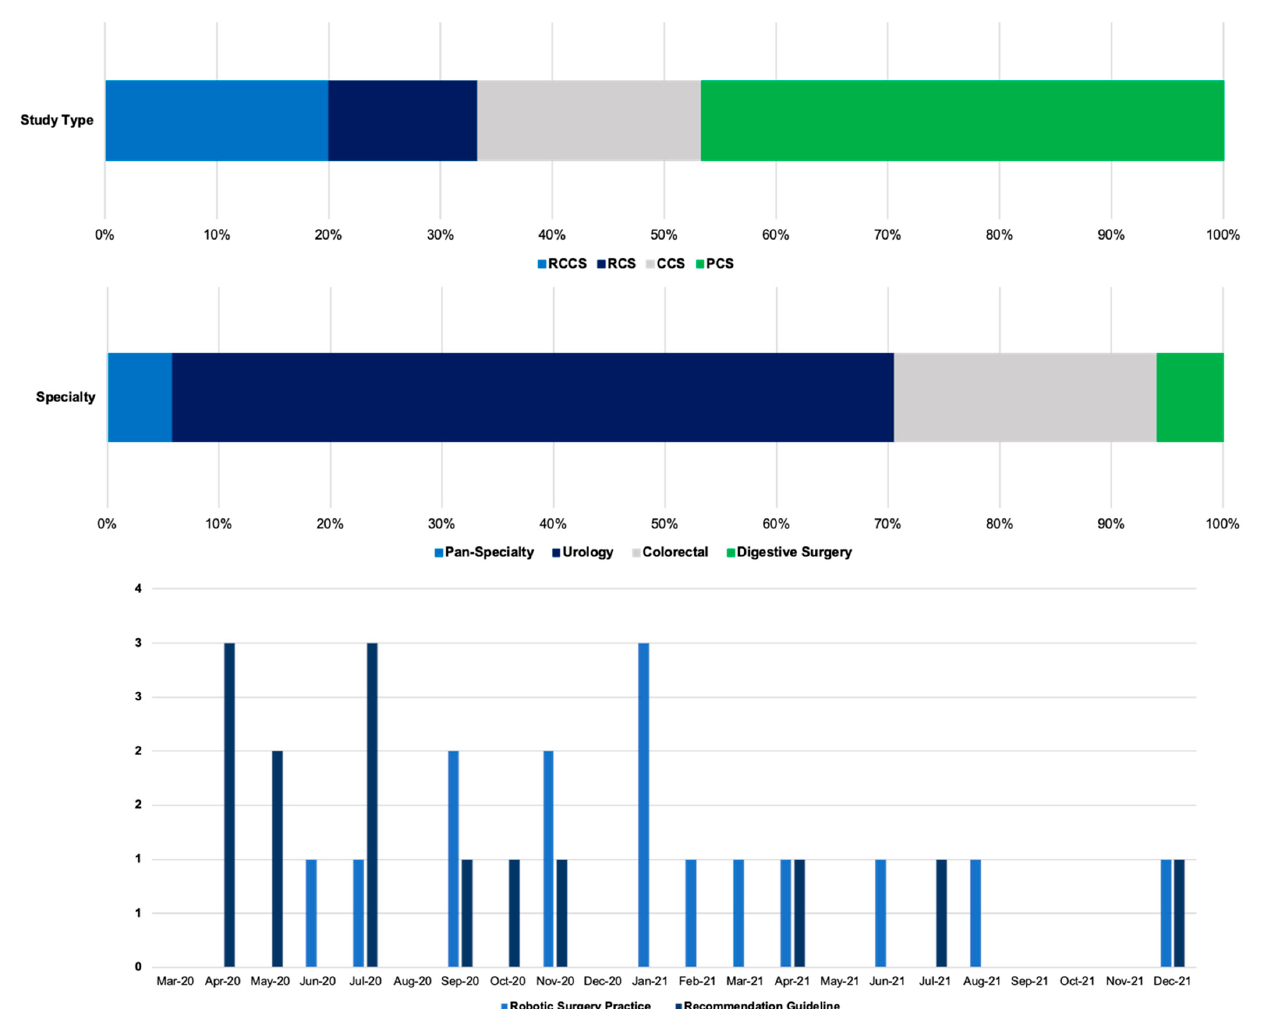
Figure 2. AGREE-II Comparison. Figure 3. Study type and relevant surgical specialty for publications related to robotic-assisted surgery practice during the COVID-19 pandemic and publication patterns of both robotic surgery practice and peer-reviewed recommendation/guideline